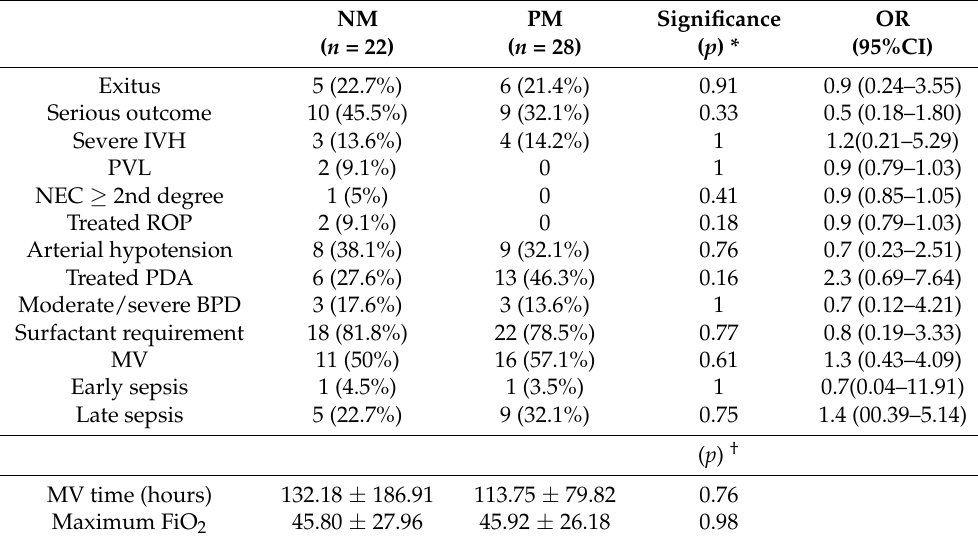
Table 3. Comparison of the tertiary hospital birth population based on the maturation pattern received.